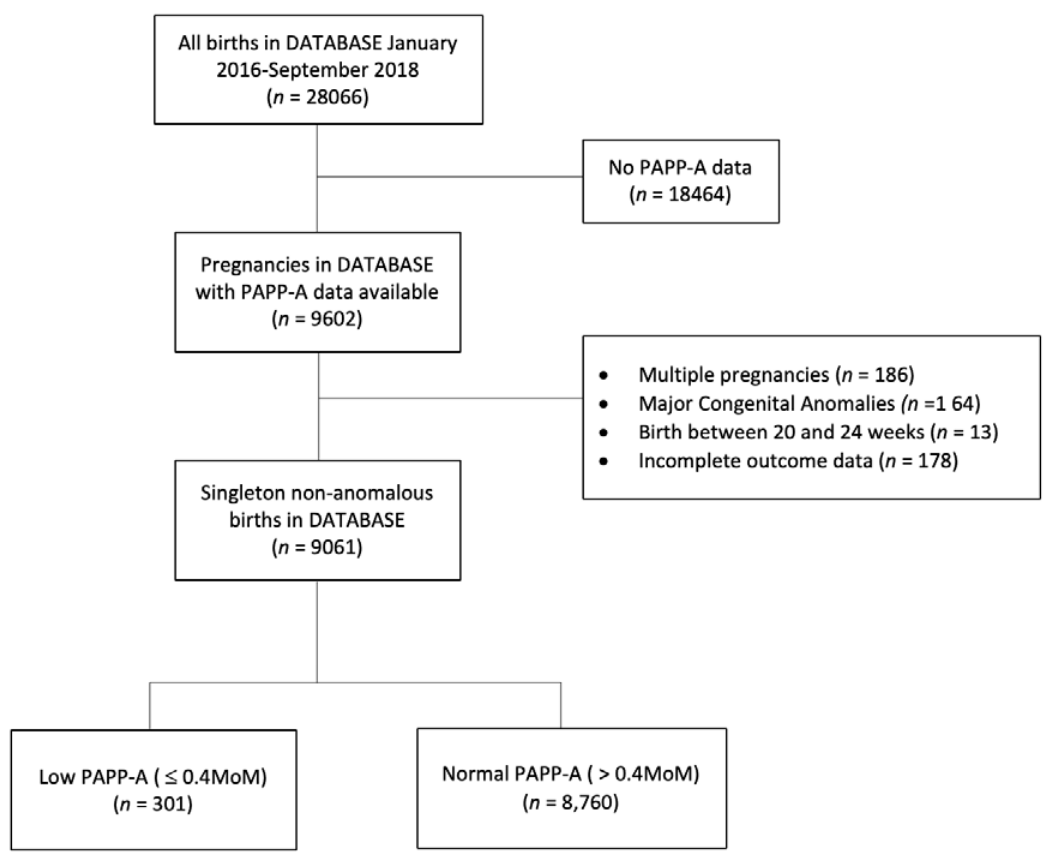
Figure 1. Study flow diagram. PAPP-A, pregnancy-associated plasma protein-A.